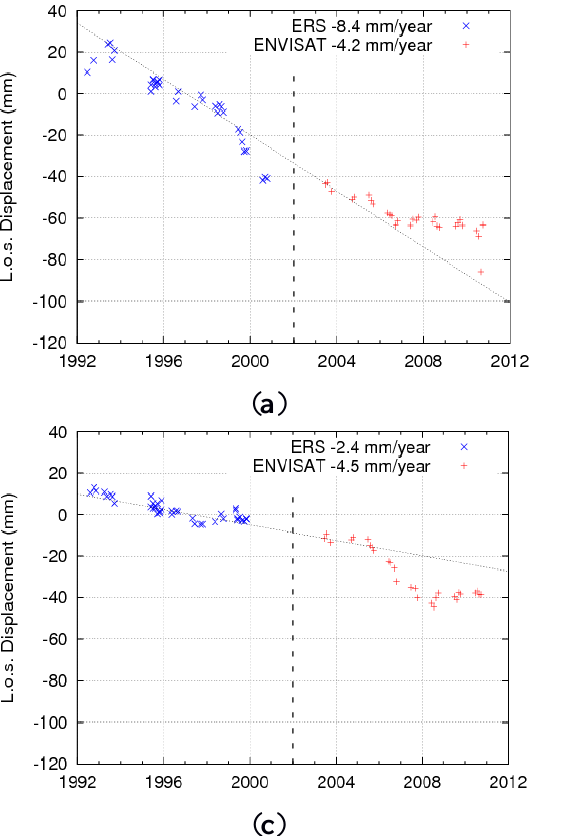
Figure 6. Time series of PSI displacement rates in the satellite line-of-sight direction for selected points. The separate solutions of the ERS and ENVISAT PSI analyses are plotted on the same graph by aligning the first acquisition of the ENVISAT time-series to the ERS average displacement rate shown with a dotted line. The geographical location of the points is indicated in Figure 5. ( a ) Upper western part of the slope; ( b ) Rossura; ( c ) Carì; ( d ) Upper eastern part of the